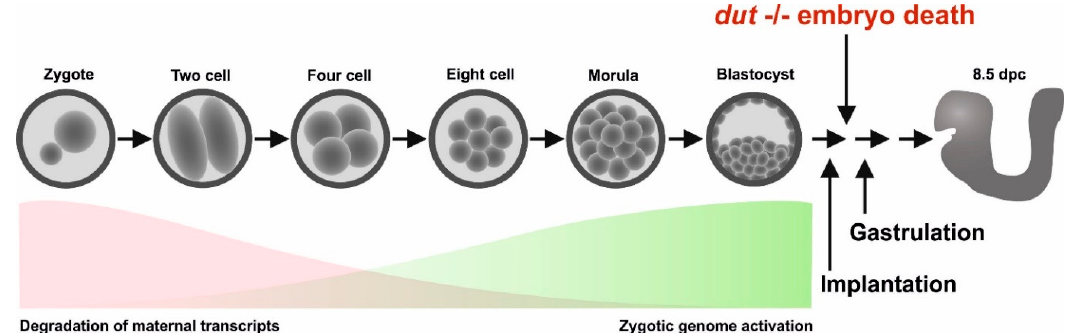
Figure 6. Schematic diagram of embryonic development in mice. The red and green areas show the timeline of simultaneous degradation of maternal transcripts and activation of zygotic transcription. Arrows illustrate that homozygous knock-out embryos die shortly after implantation.